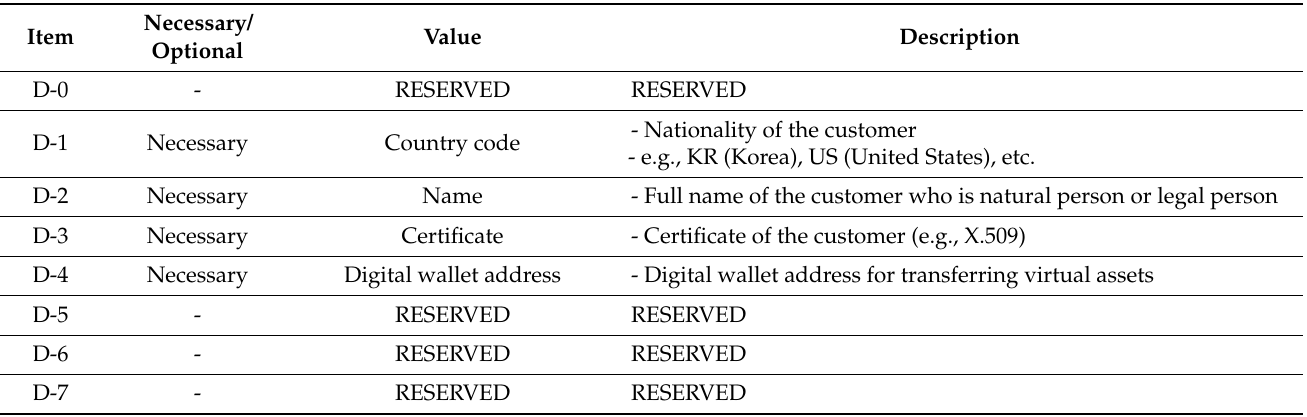
Table 3. Data format-2.